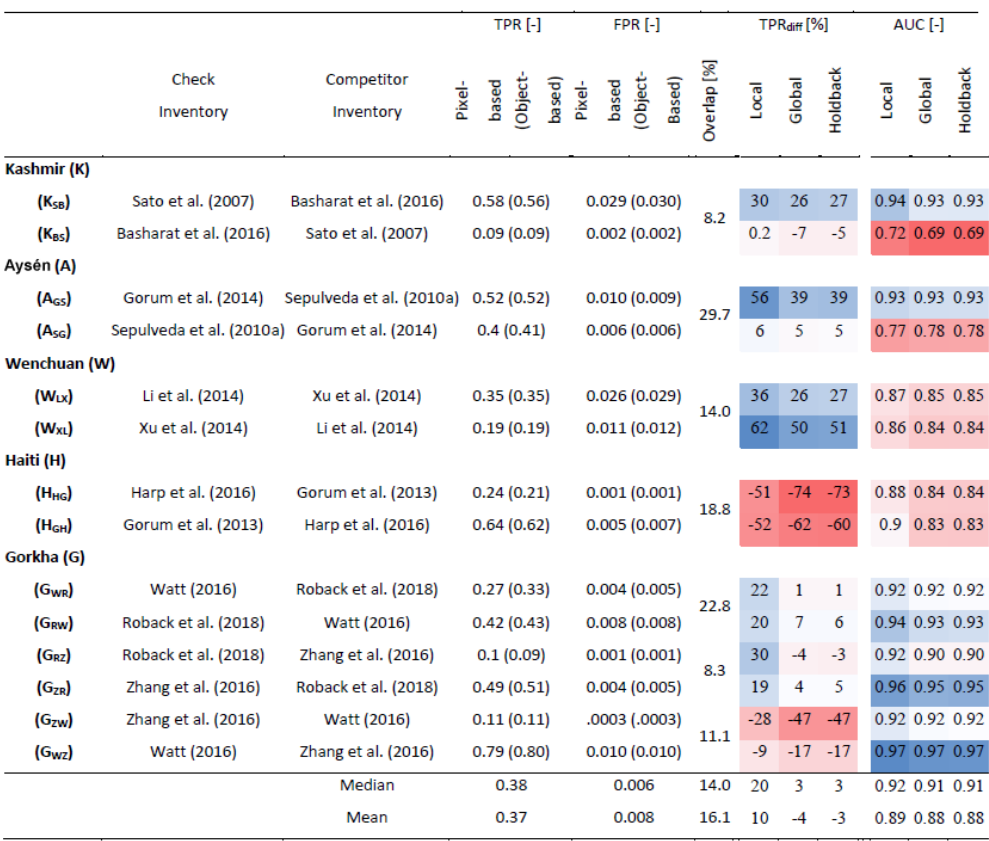
Table 3. Performance metrics for ALDI applied with the different parameter sets to identify landslide-affected areas from each of the 14 inventory pairs. Abbreviated names for the inventory pairs indicate the case study with subscripts denoting first check and then competitor inventories (e.g. K SB denotes the Kashmir earthquake with Sato as the check inventory and Basharat as the competitor inventory). The true-positive rate (TPR) and false-positive rate (FPR) are reported for both object-based analysis (in brackets) and pixel-based analysis at 30m resolution. Overlap indicates the percentage overlap between pairs of landslide inventories. Shading in right-hand columns indicates performance of ALDI relative to each competitor and for each metric and calibration, with a linear colour scale from blue where ALDI outperforms the manual competitor to red where the manual competitor outperforms ALDI. Vertical blocks reflect different performance metrics: TPR diff and AUC (see text). Columns within each block reflect different ALDI calibration strategies: local calibration optimised to both site and check inventory, global calibration using a compilation of the best parameter sets from all sites, and holdback calibration where parameter sets from the test site are excluded. Note that positive values of TPR diff reflect cases where ALDI outperforms manual mapping, while negative values reflect cases where manual mapping is